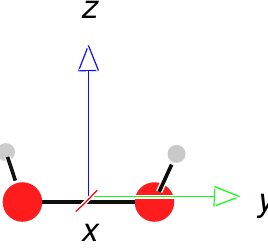
Figure 1. R α enantiomer of the hydrogen peroxide molecule.